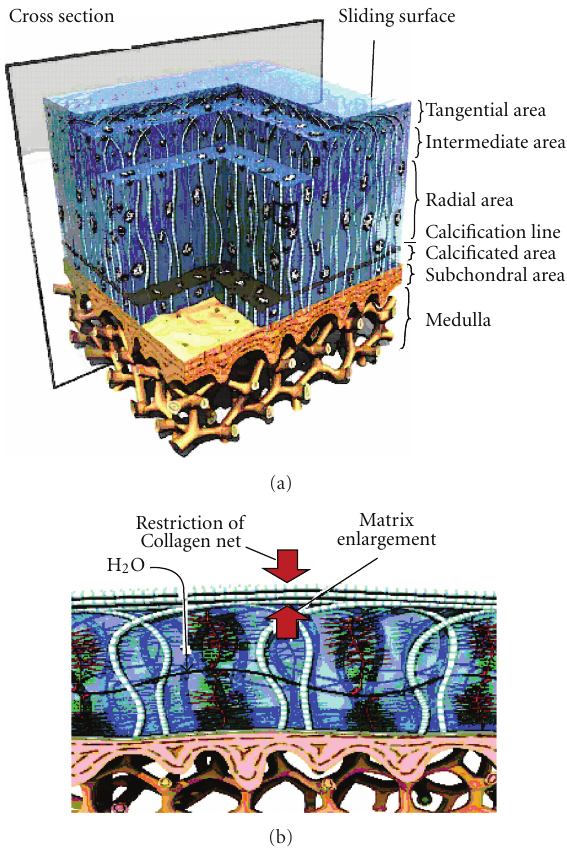
Figure 1: Structure of cartilage tissue: (a) on microlevel with em- phasized heterogeneity zones; (b) arrangement of nanosized com-